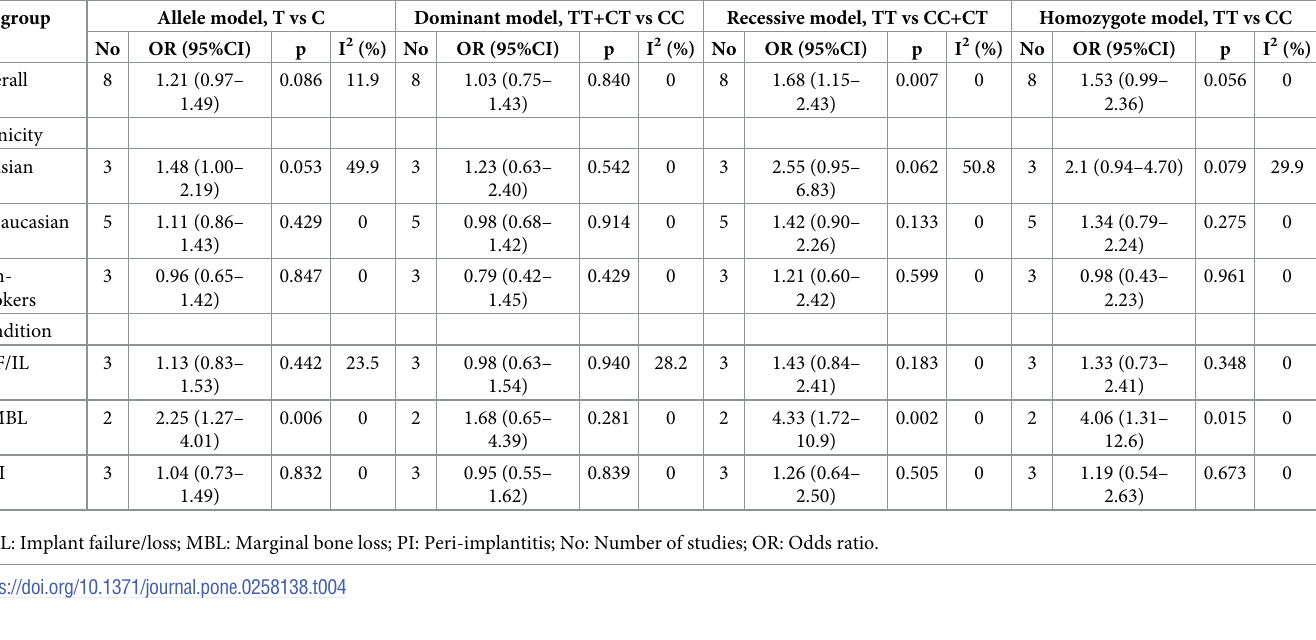
Table 4. Association between IL-1 β C-511T polymorphism and susceptibility to peri-implant disease.